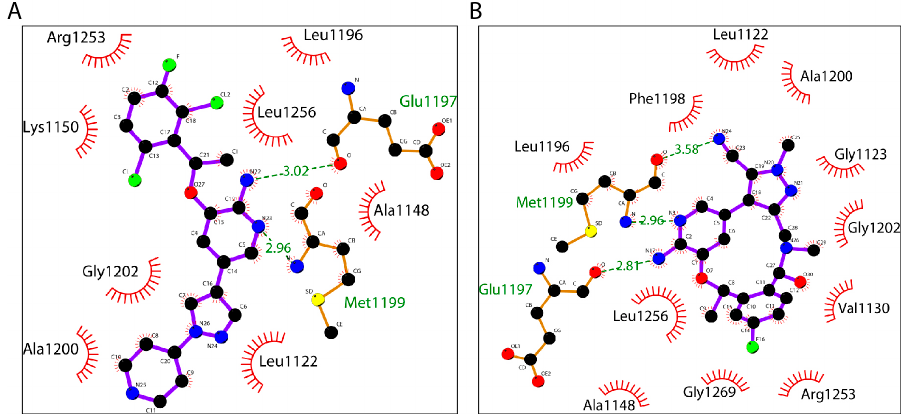
Figure 6. Two-dimensional (2D) interaction diagrams of ALK–inhibitor complexes. The 2D interaction diagrams of crizotinib ( A , PDB ID: 5AAB) and lorlatinib ( B , PDB: ID 5AA8) were generated by Ligpolt+ software. Ball and stick denotes ligands. Corresponding ALK residues are shown as wires.